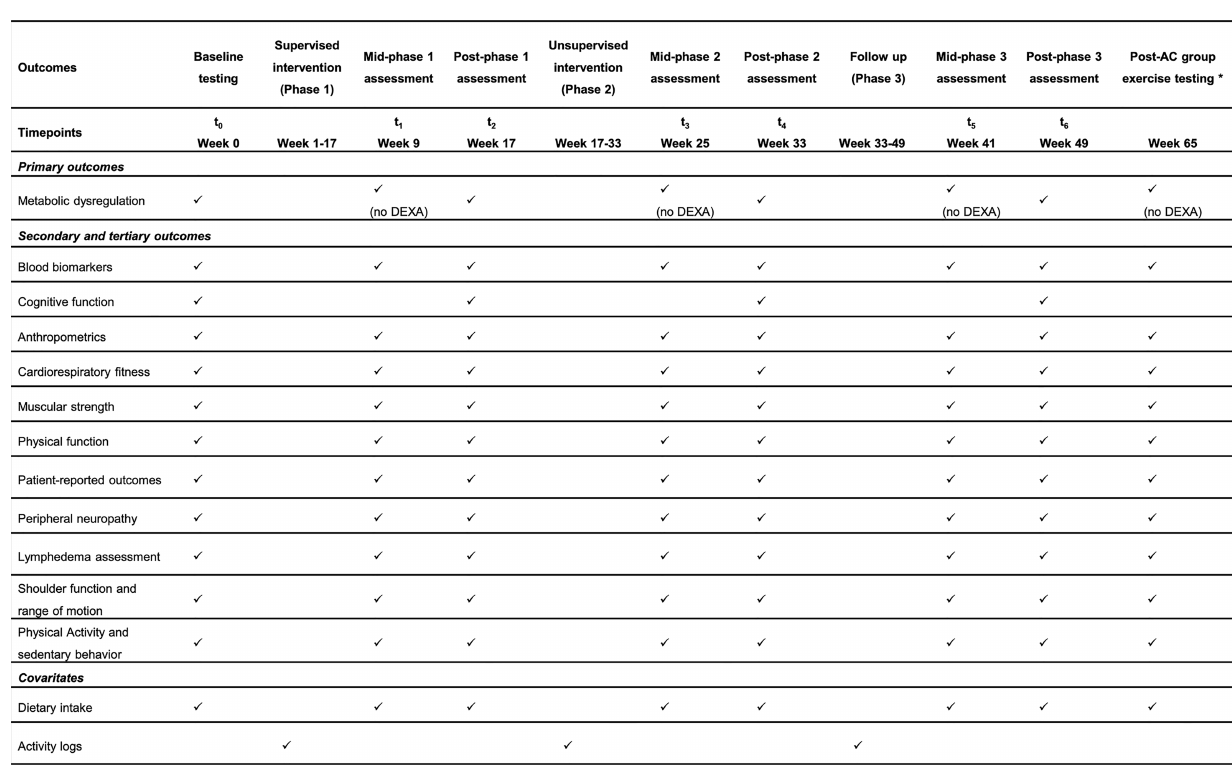
FIGURE 4 | SPIRIT fl ow diagram for study visits timeline of the ROSA Trial. DEXA, dual-energy x-ray absorptiometry; AC, attention control group. *Only for the AC who choose to complete the ACTIVAS